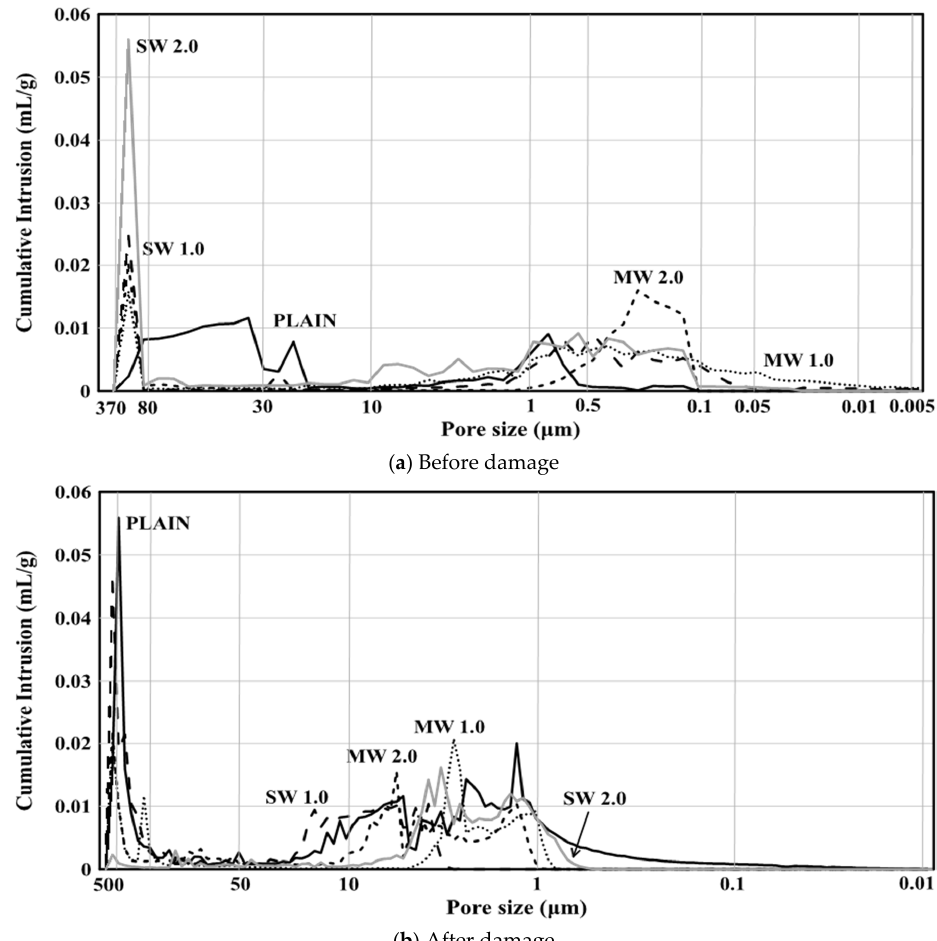
Figure 12. Pore size distribution of CNT cementitious composites before and after immersion in 5% sulfuric solution: ( a ) before damage and ( b ) after damage.